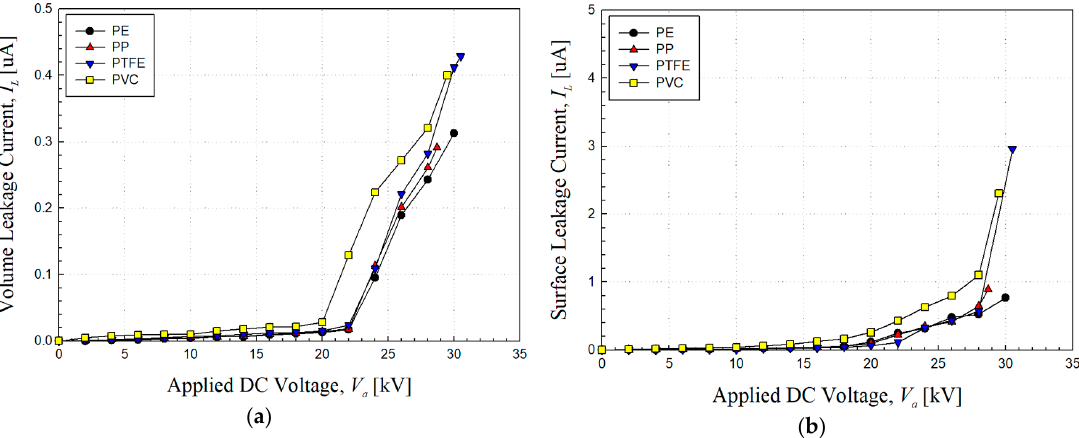
Figure 11. Volume and surface leakage current characteristics for each insulating material according to the applied DC voltage: ( a ) volume leakage current; ( b ) surface leakage current.